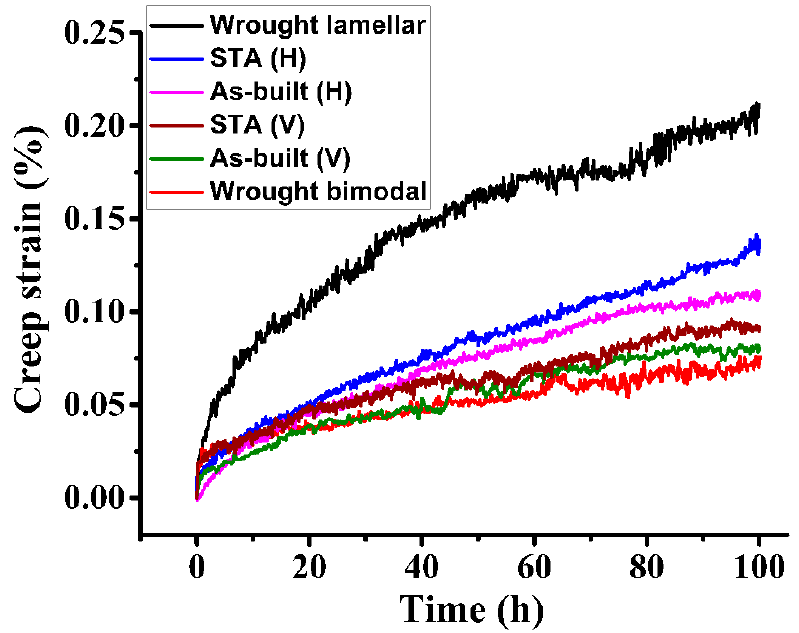
Figure 12. Tensile creep curves for the EB-DED and wrought Ti60 alloys.